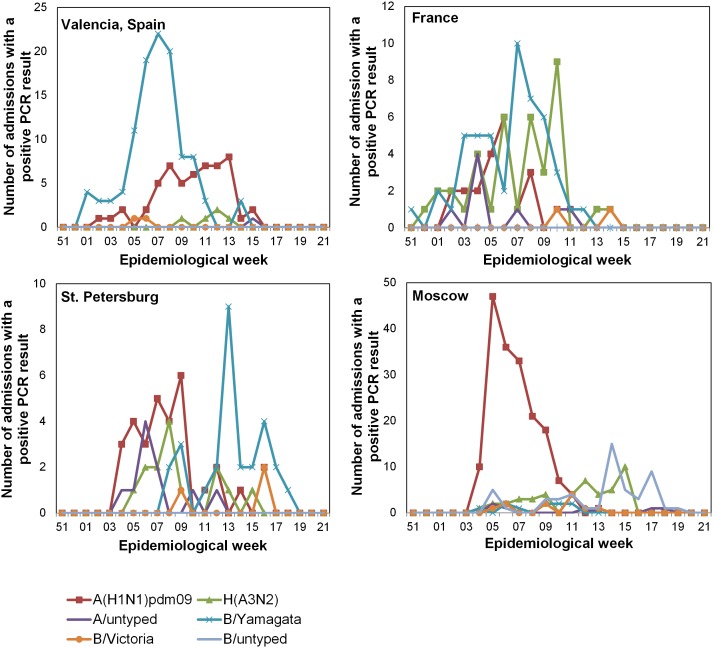
Number of admissions by epidemiological week at each site.The number of patients enrolled and included in the IVE analysis is shown by epidemiological week at each site for each influenza strain.